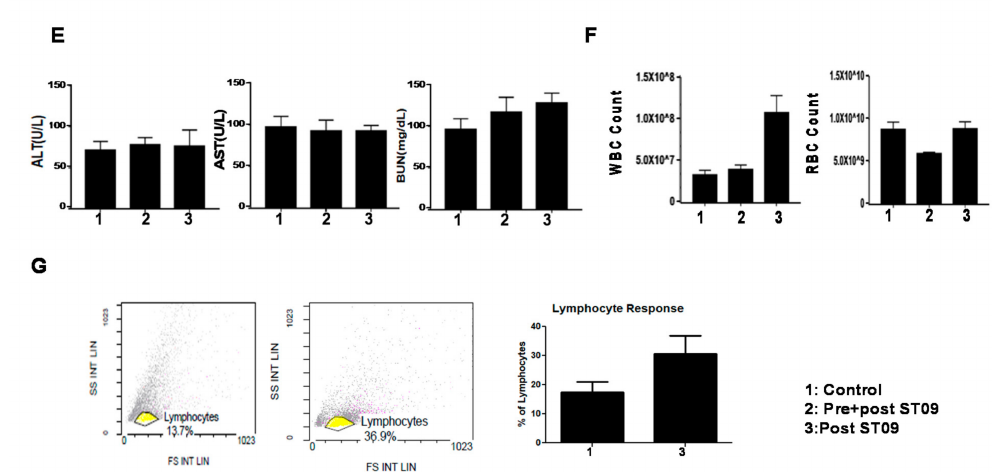
Figure 8. Evaluation of tumor reduction and organ toxicity in vivo induced by ST09: EAC cells (1 × 106 cells / animal) were injected to induce solid tumors. After the 7th day of injection, i.p injection with ST09 (10 mg / kg b.wt) was started every alternate day throughout the experiment period. For the pre + post treatment experiment, animals were pre-treated with 11 doses of ST09 (10 mg / kg b.wt), the tumor was induced, and the treatment was continued. ( A ) The gross appearance of a. control, b. ST09 post-treatment, c. ST09 pre + post treatment, d. normal mice e. control tumor, f. ST09 post-treatment tumor, g. ST09 pre + post treatment tumor, h. normal thigh, i. Control spleen, j. ST09 post-treatment spleen, k. ST09 pre + post treatment spleen, l. normal spleen. ( B ) Tumor volume after ST09 pre + post and post-treatments. ( C ) Bodyweight of animals at the end of the study. ( D ) Histopathological analysis of tumor and organs after ST09 treatment. At the end of the study, tumor tissue and organs were collected and used for histological analysis. Representative images of H&E stained sections of a. control tumor, e. ST09 post-treatment tumor b. control kidney, f. post-treatment kidney, c. control liver, g. ST09 post-treatment liver d. control spleen, h. ST09 post-treatment spleen. ( E ) Blood ALT, AST, and urease test results were plotted as a bar graph. Blood was collected at the end of the study. ( F ) WBC and RBC counts of experimental animals plotted as a bar graph. ( G ) Flow cytometry analysis of bone marrow cells showing forward scatter vs. side scatter plot. Lymphocytes were gated and analyzed. Quantification of lymphocyte response is plotted as a bar graph post ST09 treatment. Each experiment was repeated twice and represented as